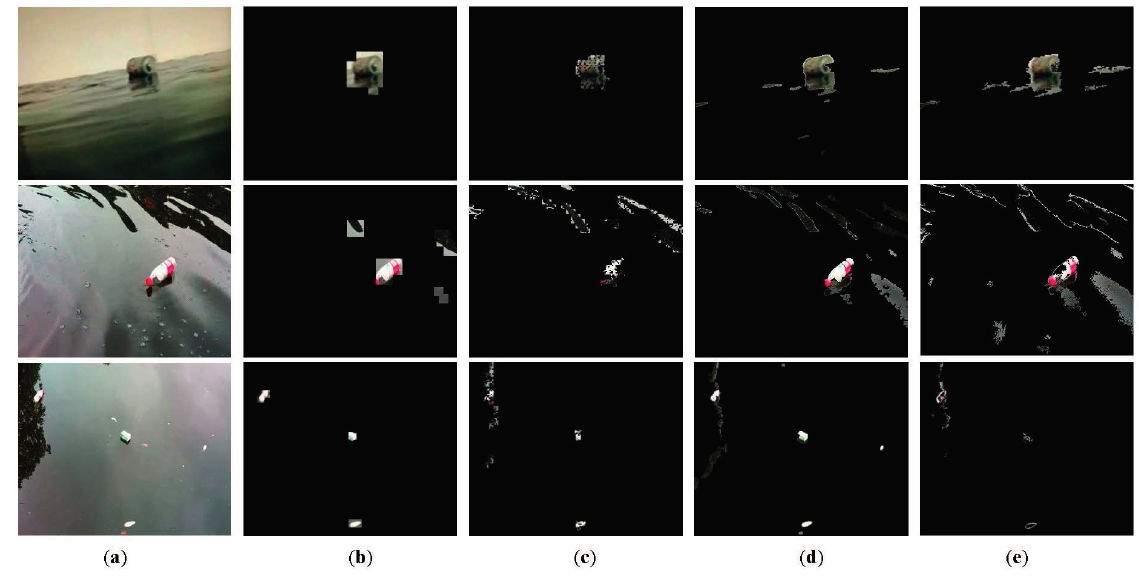
Figure 10. Comparative foreground extractions of four methods. ( a ) Original frames; ( b ) Our approach with 16 × 16 block size; ( c ) CS-MOG; ( d ) ViBe; and ( e )